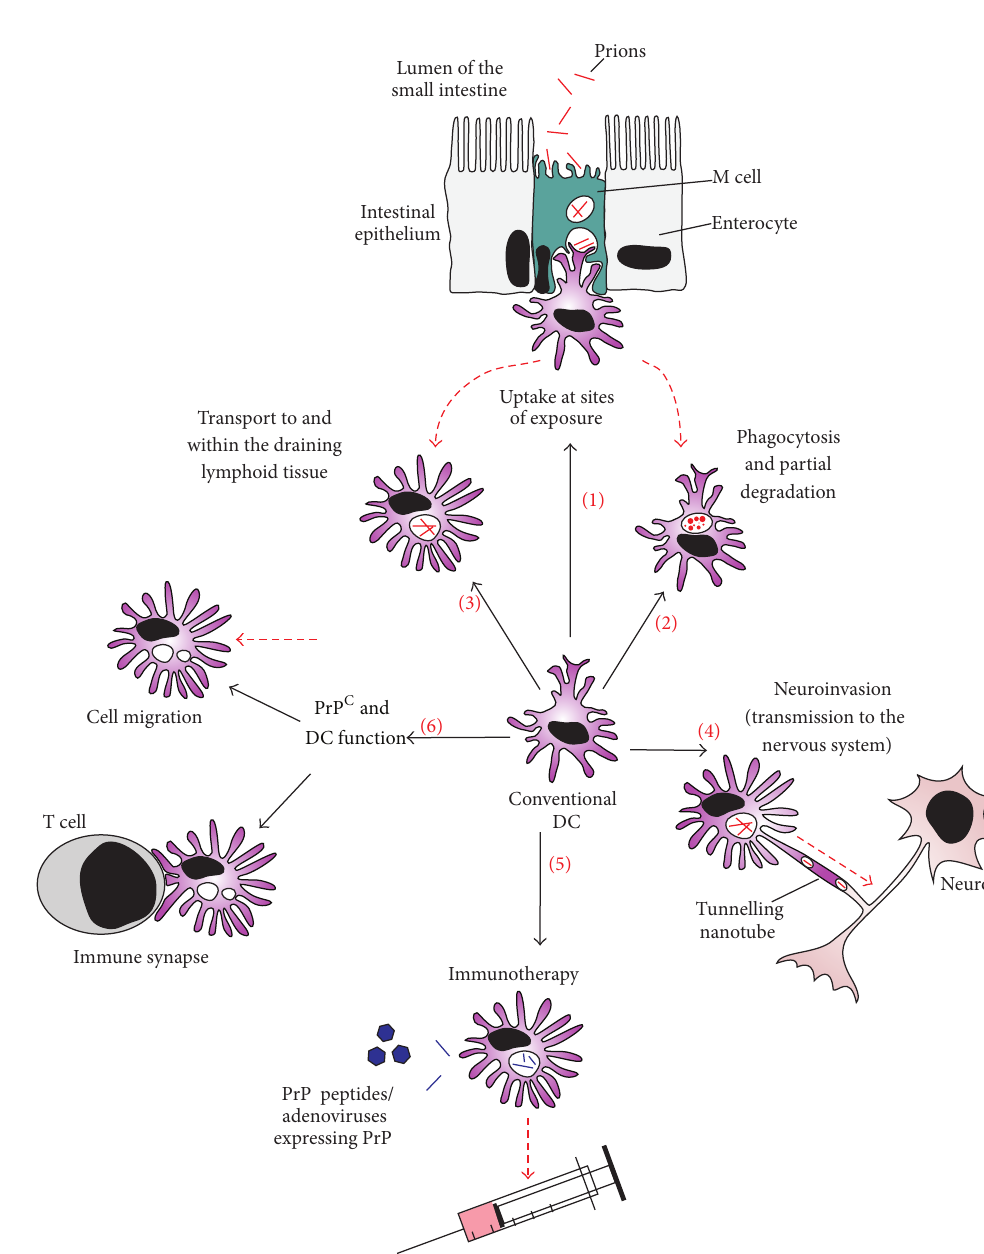
Figure 4: The influence of DC on prion disease pathogenesis. (1) Conventional DC are strategically placed throughout the mammalian host and are amongst the first cell populations to interact with prions. Following their uptake of prions DC have been proposed to exert a diverse range of contrasting effects on prion disease pathogenesis which may have a significant outcome on the spread of infection to the CNS. (2) Some studies have suggested that DC may help to protect the host against infection by attempting to sequester and destroy the prions [25–29]. (3) Others suggest that prions may exploit the migratory characteristics of DC to facilitate their efficient propagation from the site of exposure to the lymphoid tissues [22–24, 34, 39]. (4) DC may also play an important role in the subsequent transfer of prions to the CNS by bridging the gap between the immune and peripheral nervous systems [36, 61, 91–93]. (5) The adoptive transfer of PrP peptide-loaded DC into mice can overcome host tolerance towards PrP and prolong survival time after prion infection. This implies that DC could be manipulated to provide immunotherapeutic protection against prion diseases [54, 106, 107]. (6) The physiological function of cellular PrP C is uncertain but in DC may play a role in the immune synapse or in the regulation of cell migration [51,